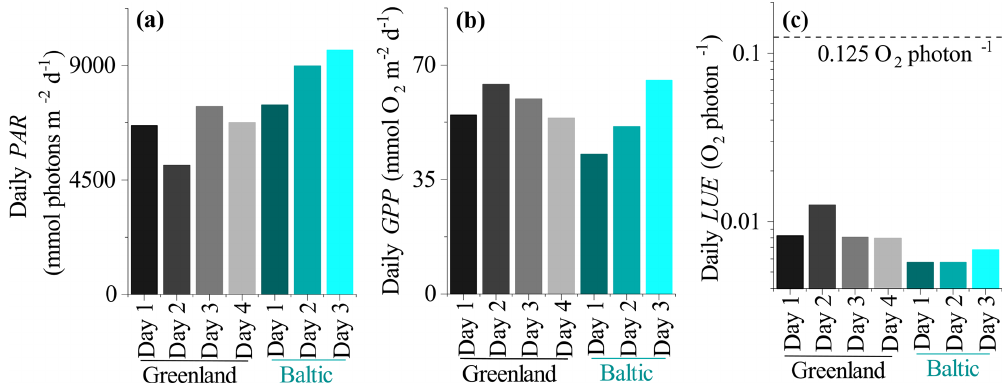
Figure 7. (a) Daily seabed PAR, (b) daily benthic GPP, and (c) daily LUE. The broken line in (c) indicates the theoretical limit of 0.125O 2 per photon.